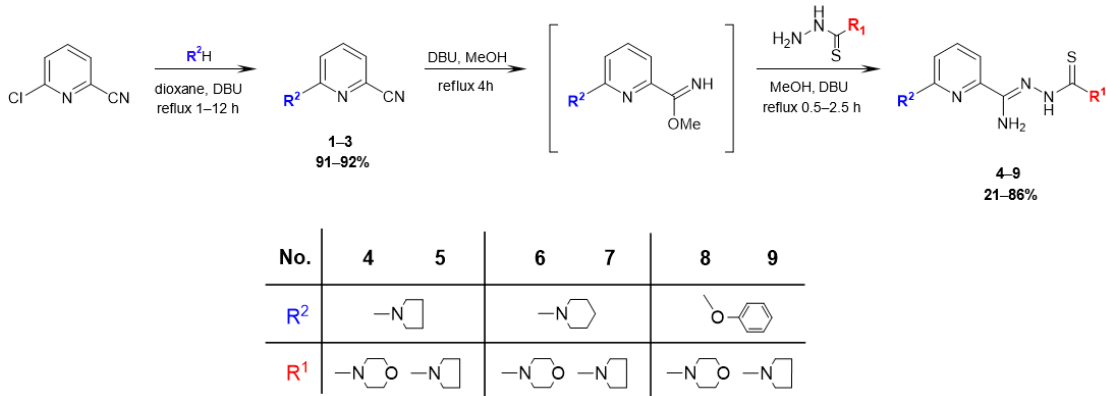
Figure 2. Synthesis of 2,6-disubstituted thiosemicarbazone derivatives of pyridine 4 – 9 .